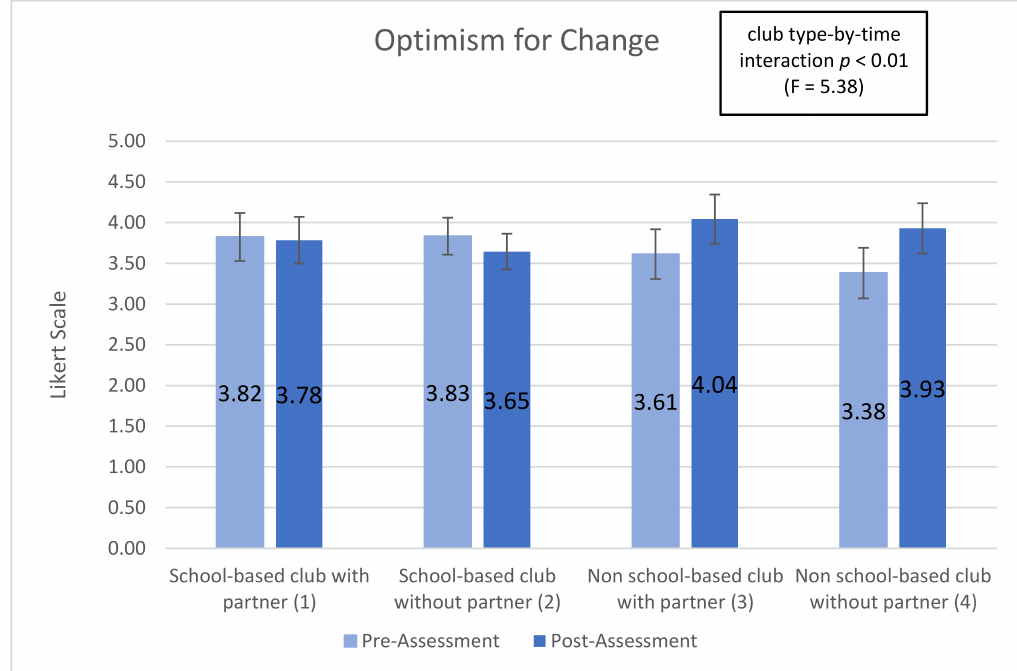
Figure 1. Optimism for Change pre- post-assessments by club type and partnership.